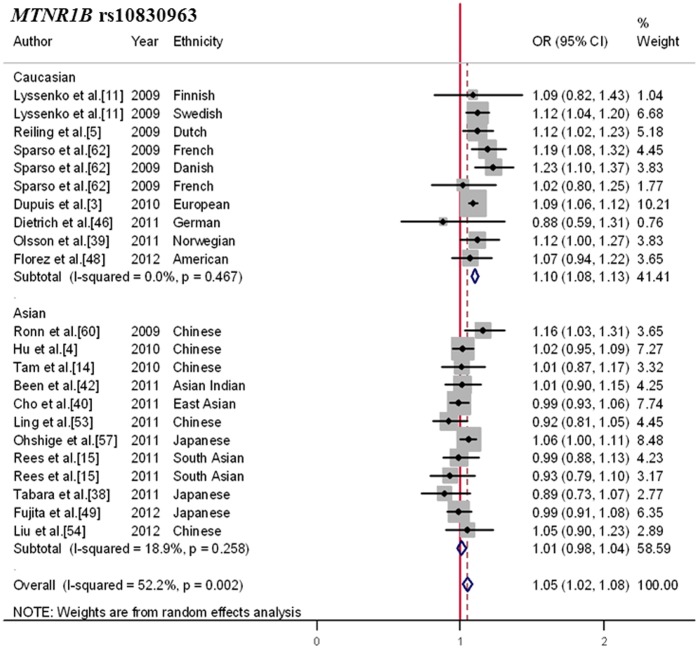
Forest plot for the association between MTNR1B rs10830963 and T2DM.Pooled OR for the additive genetic model was shown under a random-effects model. Square sizes were proportional to weight of each study in the meta-analysis. The result indicated that significant association was limited to Caucasians.